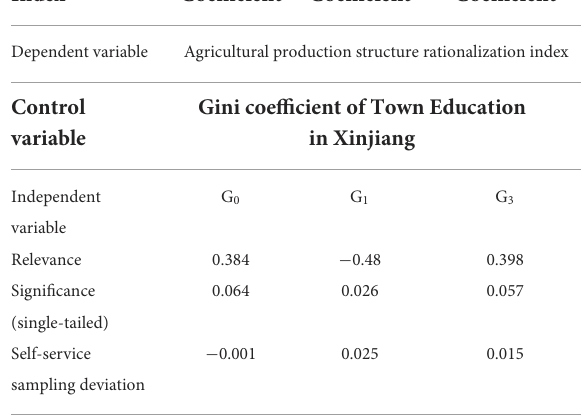
TABLE 8 Partial correlation analysis